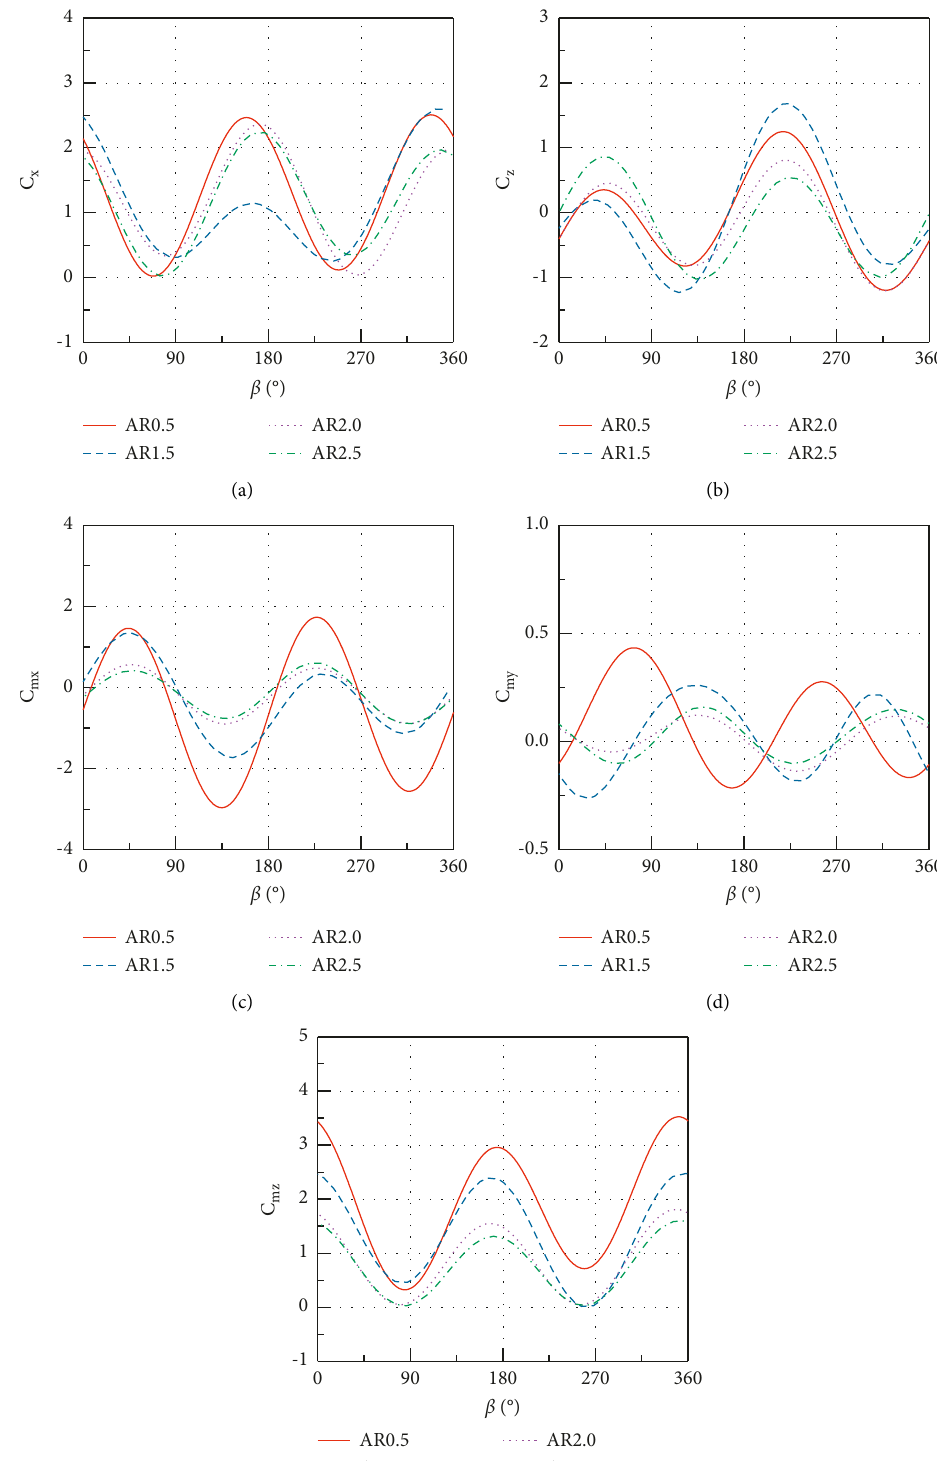
Figure 6: Aerodynamic coefficients with respect to the aspect ratio: (a) C